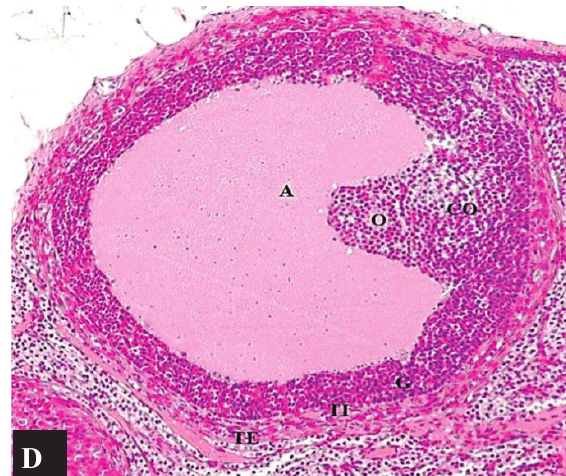
Fig-4A: Showing normal Graafian follicle of control group A. (H&E, 20x).